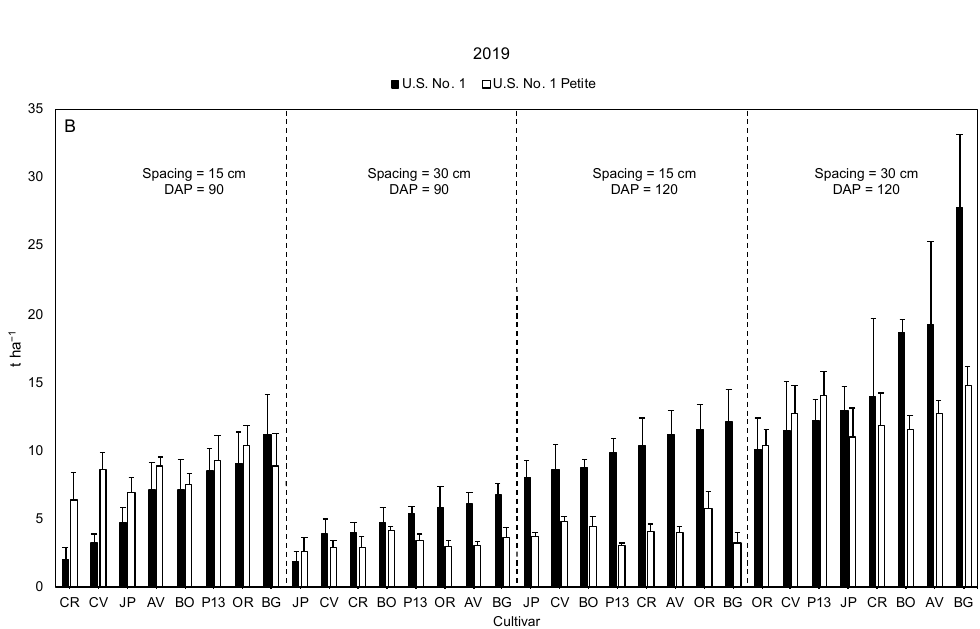
Figure 5. The yield of U.S. No. 1 and Petite sweetpotato roots under 15 cm and 30 cm in-row spacing and harvested at 90 or 120 days after planting in the 2018 ( A ) and 2019 ( B ) field season. Varieties are ‘Averre’ (AV), ‘Beauregard’ (BG), ‘Bonita’ (BO), ‘Carolina Ruby’ (CR), ‘Covington’ (CV), ‘Murasaki’ (MS), ‘NC413’ (413), ‘Orleans’ (OR), ‘Japanese’ (JP), and ‘NCP13-0030’ (P13). DAP = days after planting.